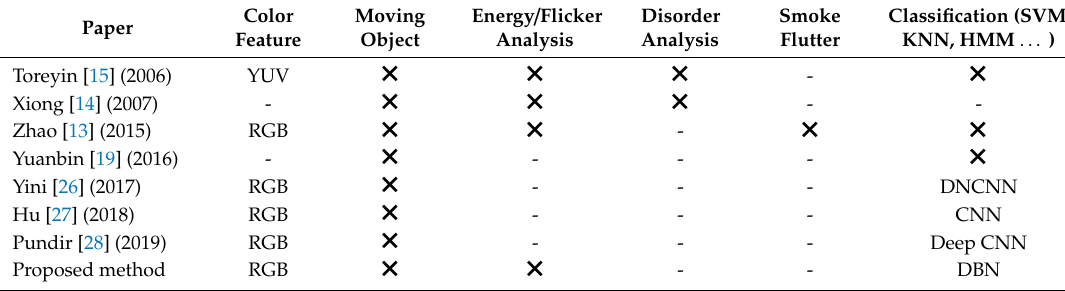
Table 1. State of art of smoke detection methods.